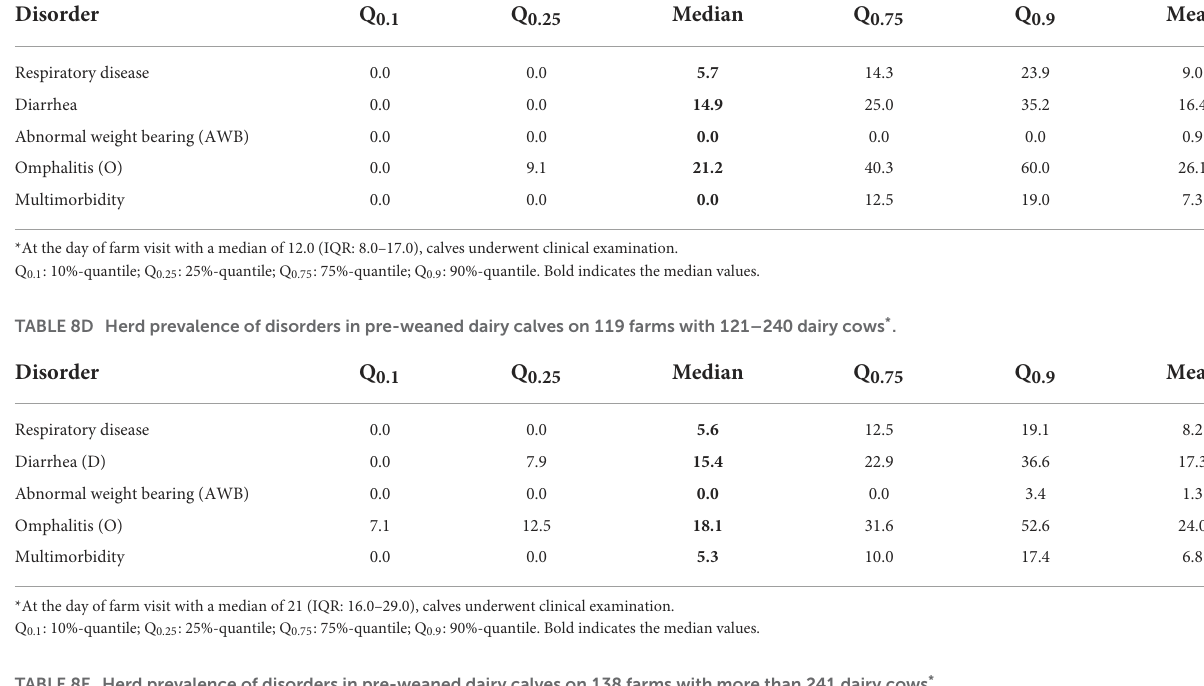
TABLE 8E Herd prevalence of disorders in pre-weaned dairy calves on 138 farms with more than 241 dairy cows * . Disorder Q 0.1